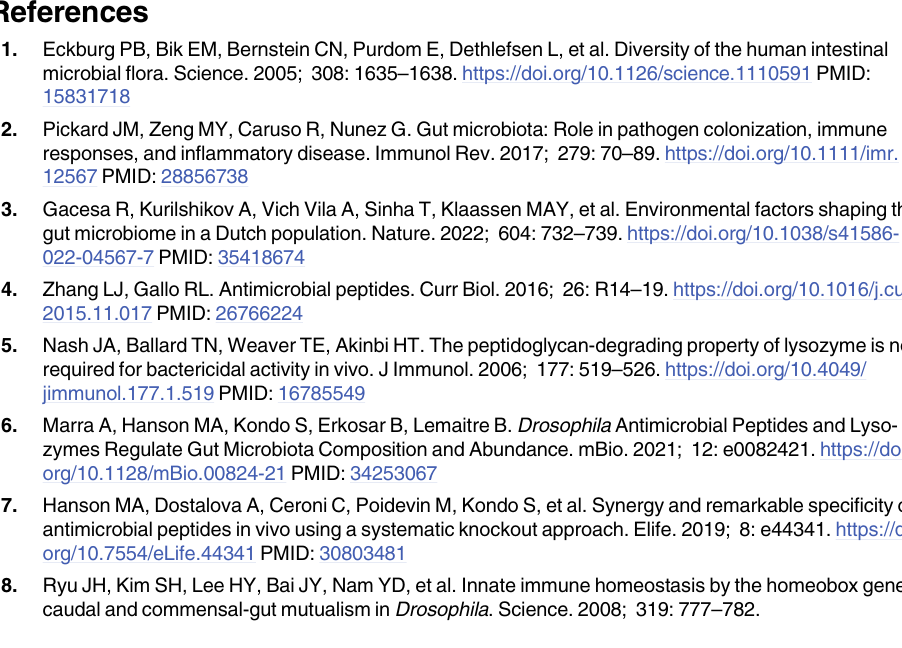
S1 Table. Detailed information of RNA-seq results. S2 Table. Primers and peptides used in this